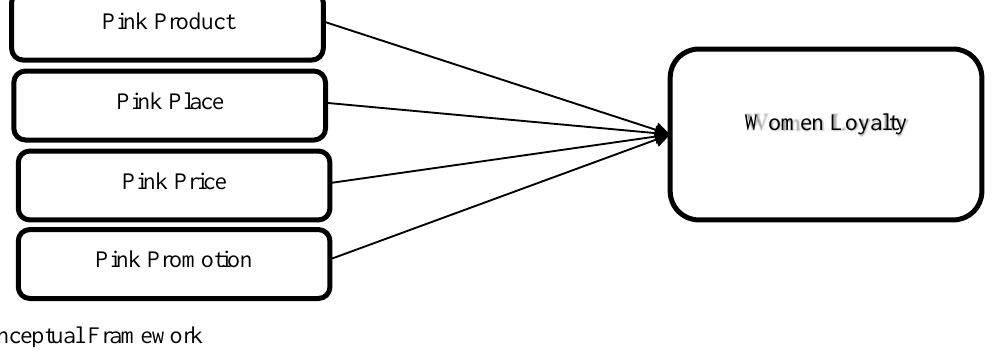
Figure 2: Conceptual